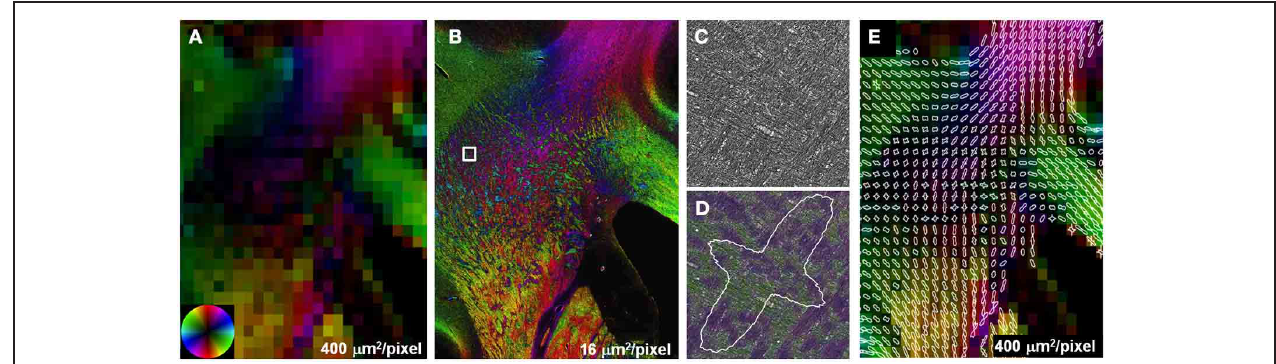
FIGURE 3 | Partial volume effects and crossing fibers. Anisotropy in regions containing multiple intersecting fiber tracts was lower compared to single, coherent fiber pathways (A) . Reconstructions at higher resolution (B) improve the visualization of small, interdigitated fiber bundles in the region